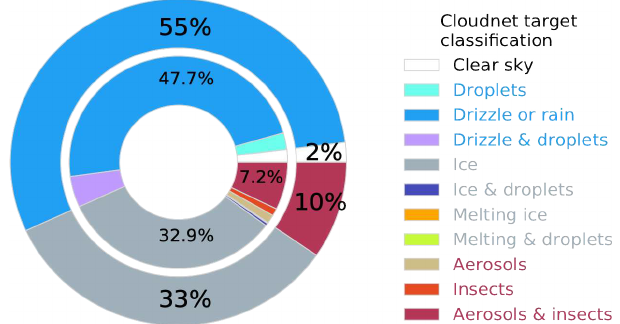
Figure 6. Relative frequency of occurrence of the CloudNet tar- get classification results within virga identified by the Virga-Sniffer. The inner ring displays the percentage of the individual CloudNet target classifications, whereas the outer ring shows the portion of grouped CloudNet target classes for liquid-only, ice-containing, and aerosols and insects indicated by the label color in the